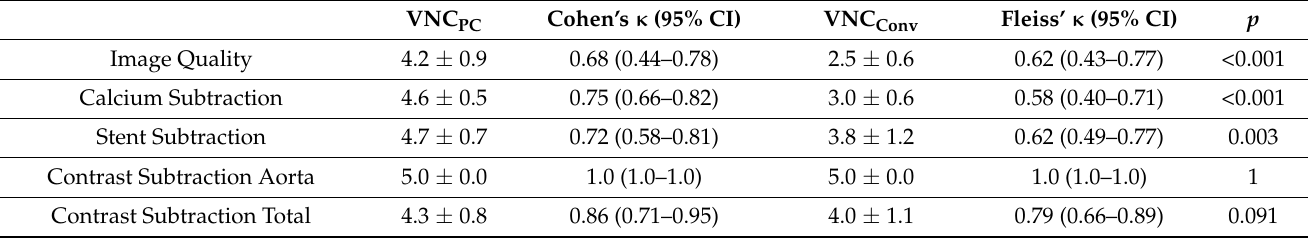
= 11) and patients scanned with a pitch of 1.5 (d.n.s.). Table 3. Qualitative CT parameters compared between VNC PC - and VNC Conv